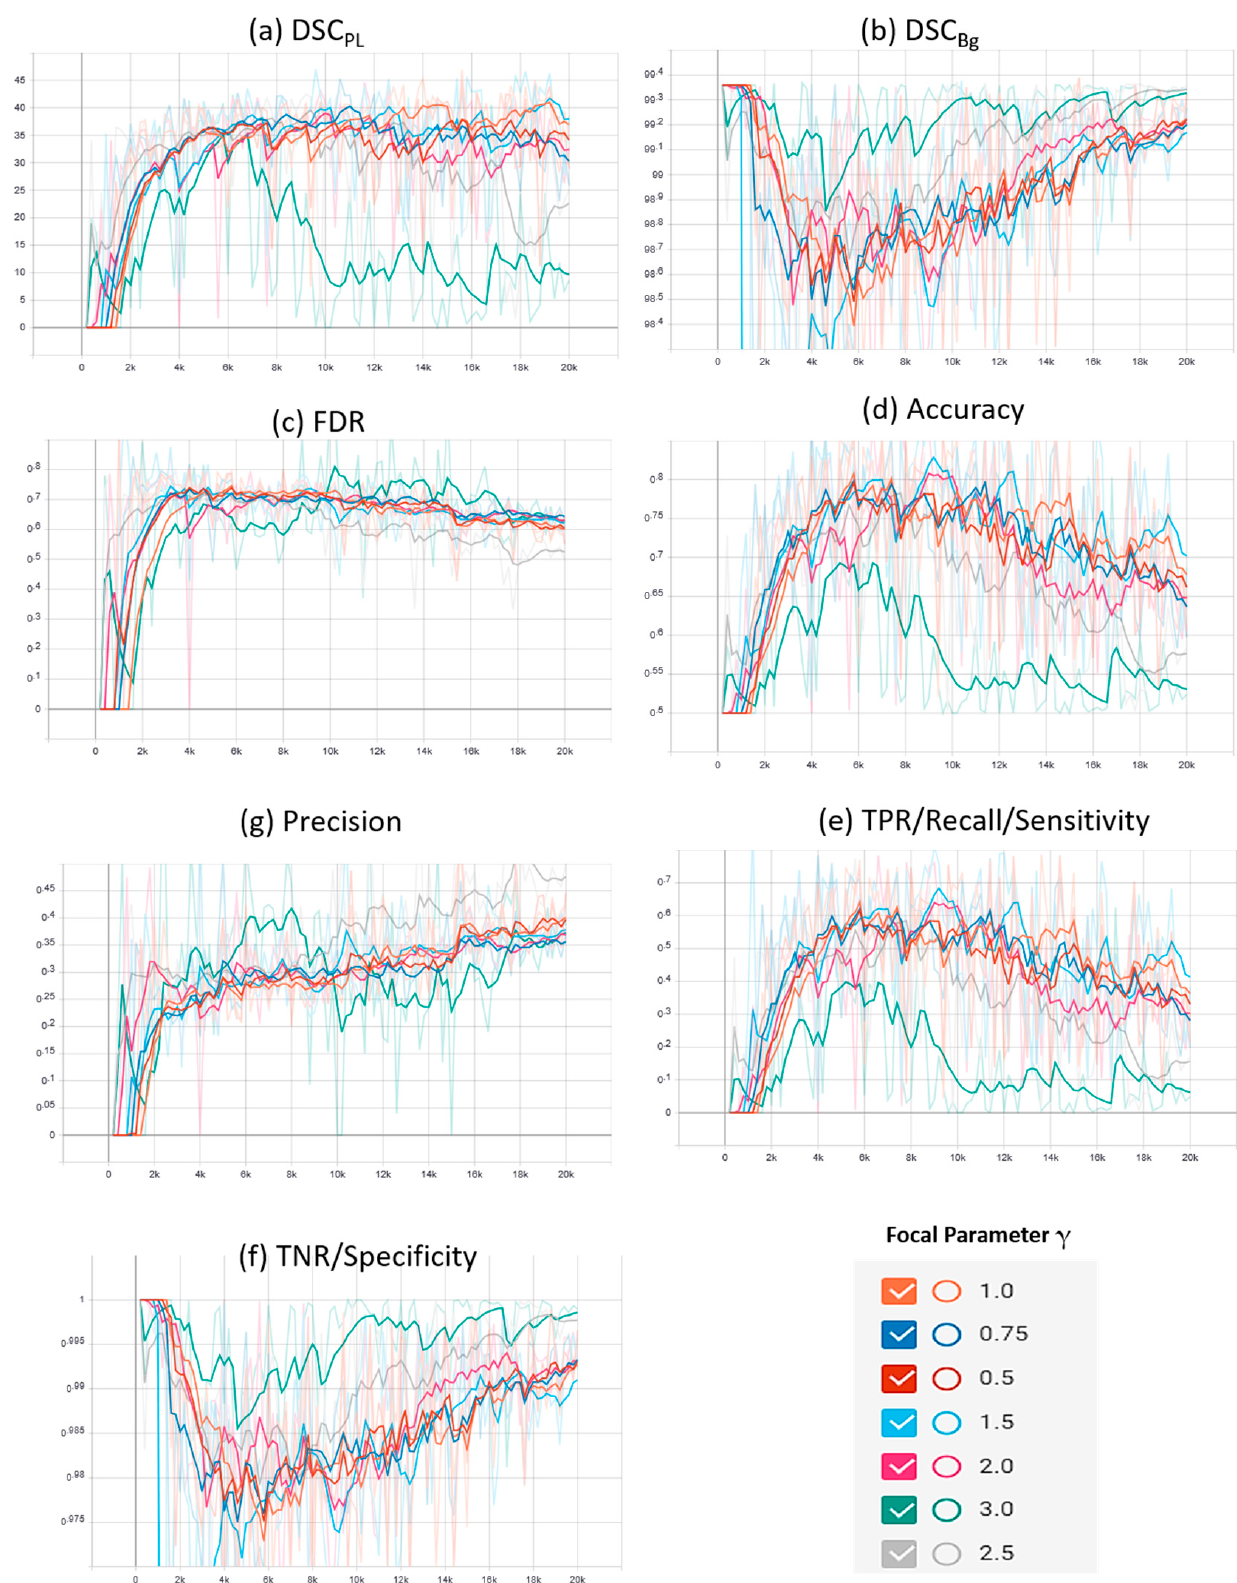
Figure 4. Characteristic evaluation parameters for the proposed focal Phi loss (FPL) function (with various values of focal parameter γ ) and the MCC loss (with γ = 1.0) on PLDU.